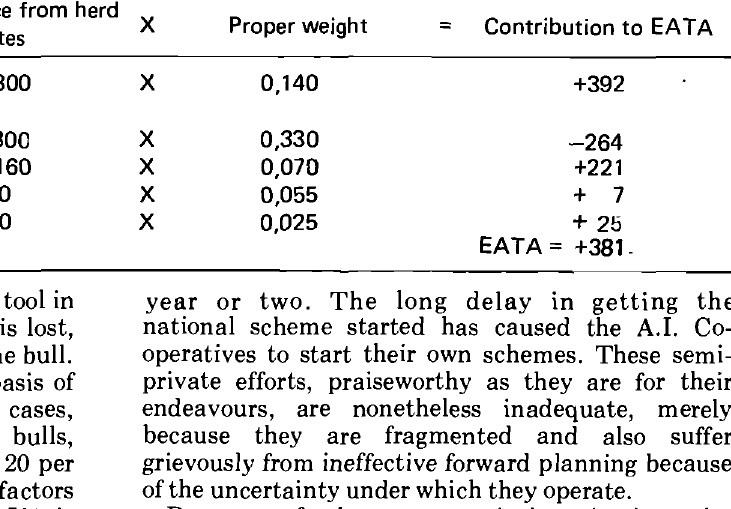
--- Table 6: CALCULATION OF ESTIMATED AVERAGE TRANSMITTING ABILITY (EATA) OF A COW . Av. difference from herd Source of information